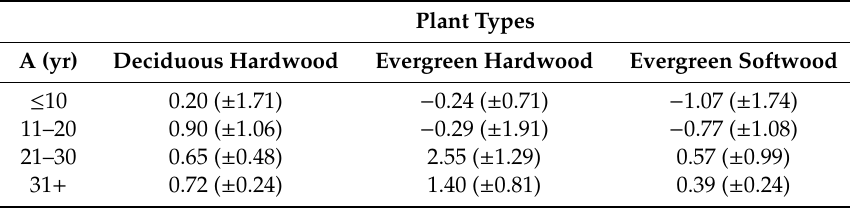
Table 2. Soil organic carbon (SOC) storage change (Mg ha − 1 yr − 1 ) of di ff erent age groups after a ff orestation with various tree types (0–60 cm